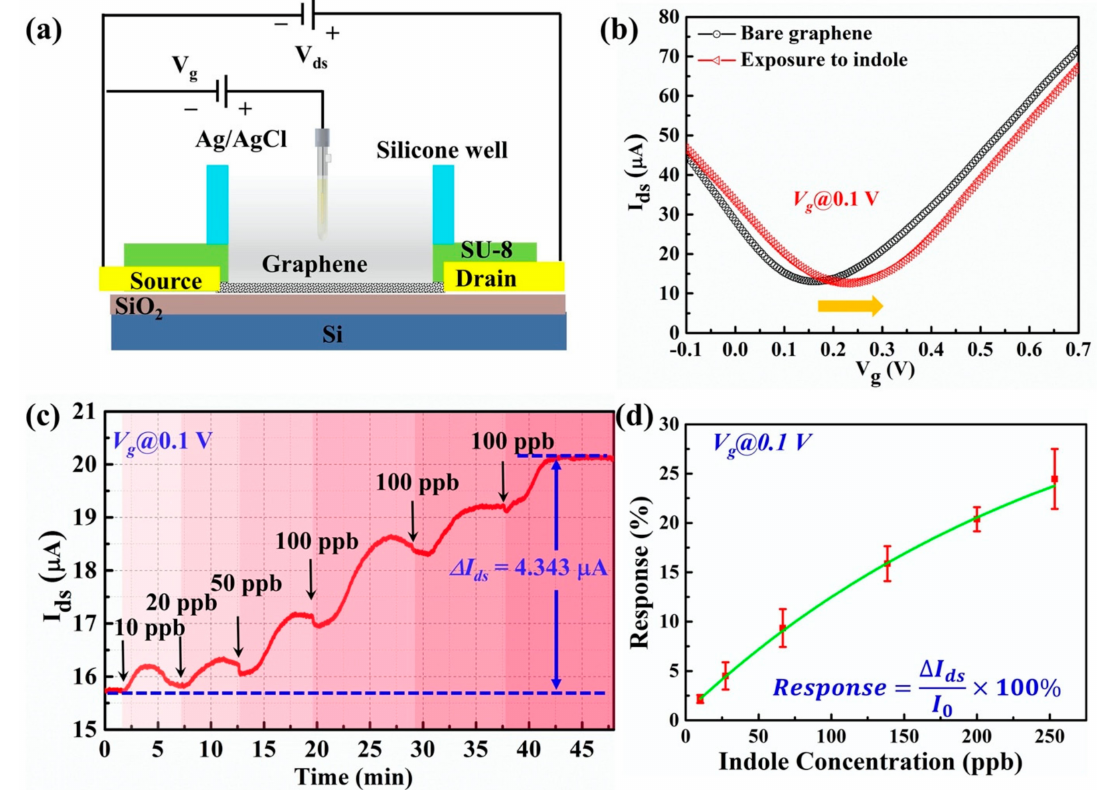
Figure 5. ( a ) The experimental setup of liquid-phase indole detection. ( b ) The transfer characteristics of graphene channel before and after the exposure of indole. ( c ) The real-time detection of indole solution using the G-FET biosensor. ( d ) The correlation between the electrical responses and various concentrations of the indole